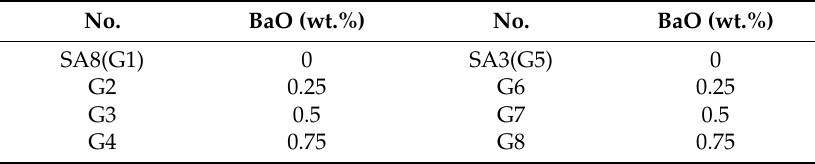
Table 2. Chemical composition of slag mixed with trace